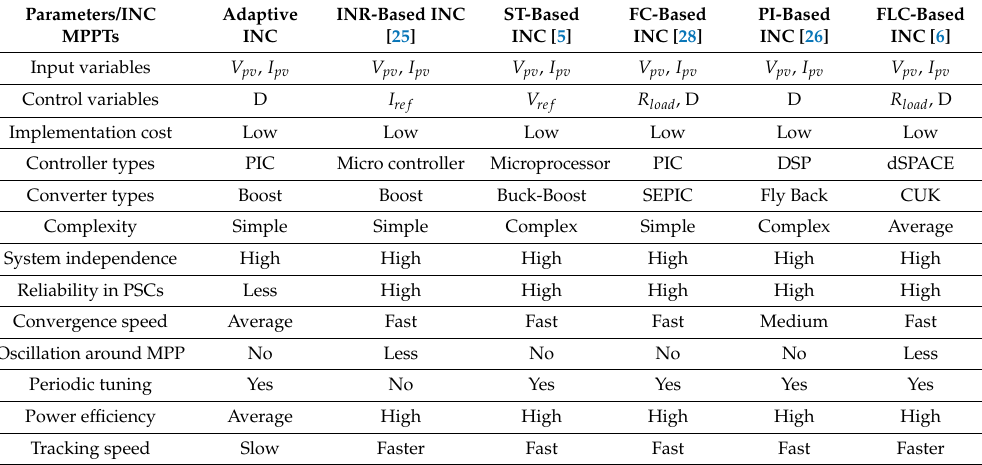
Table 1. Comparison of INC